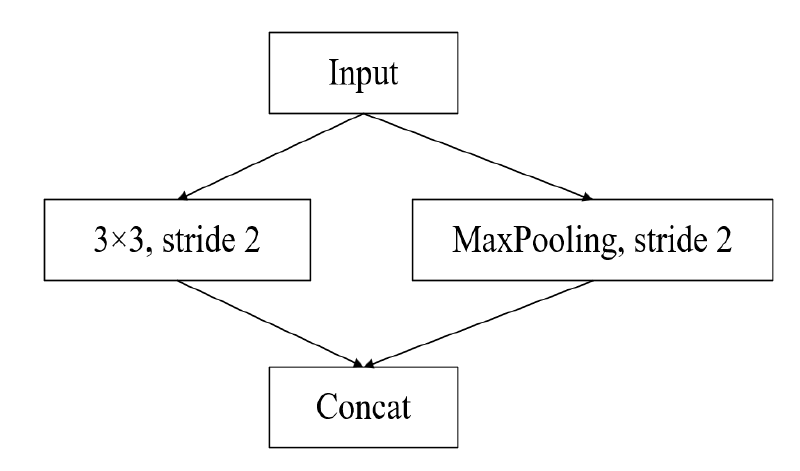
Figure 6. Downsampling block.